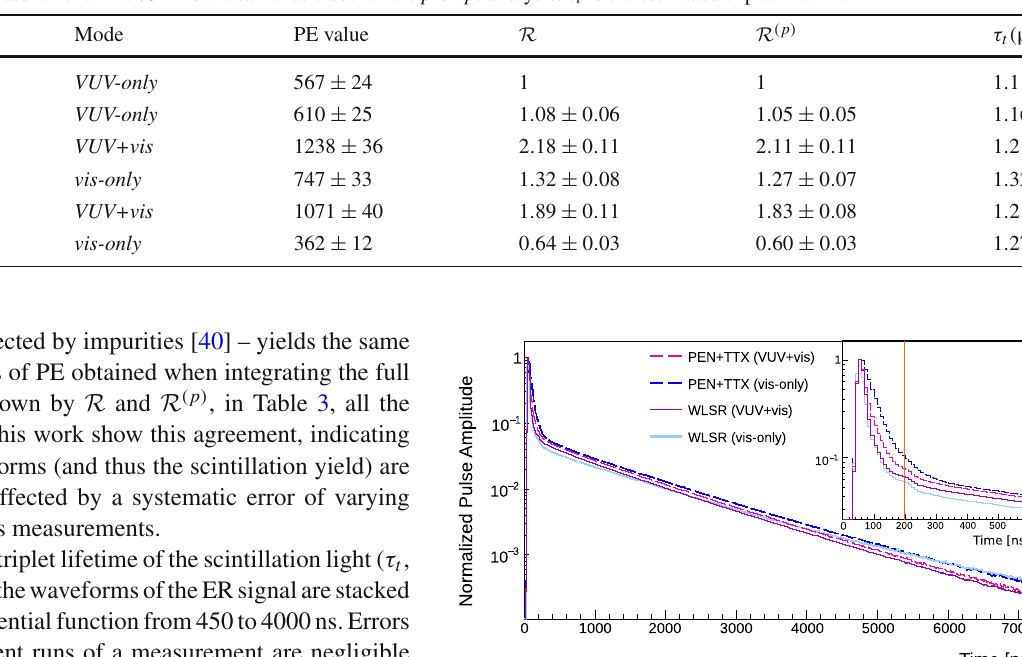
Table 3 List of measurements and detected PE values for each measurement mode. R indicates the intensity of light detected relative to the reference absorber measurement. The R ( p ) is the same ratio but for the prompt analysis. τ t is the estimated triplet lifetime